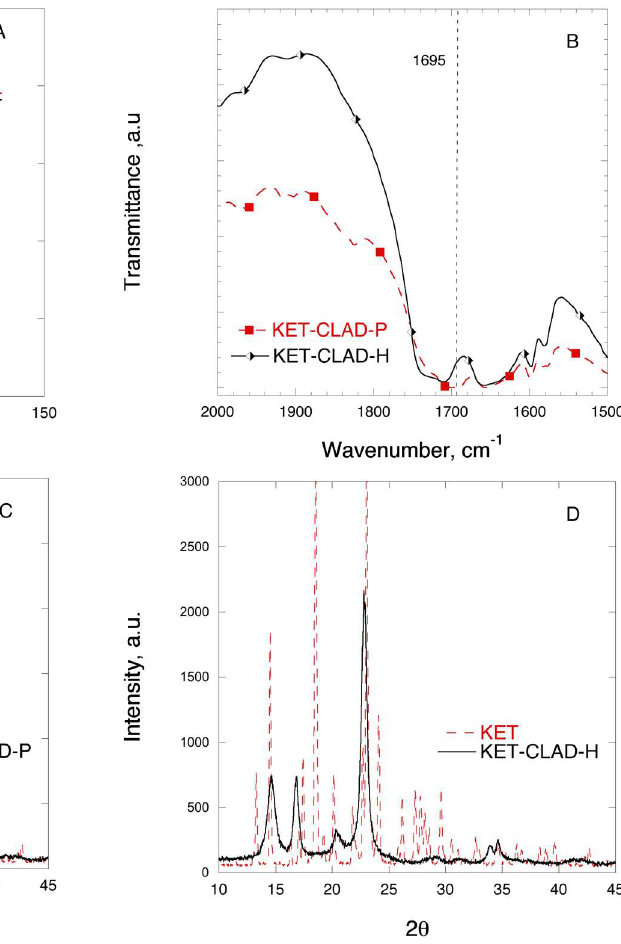
Figure 8. Solid-state analysis of KET-CLAD 10% w / w mixtures: ( A ) DSC, ( B ) FTIR, ( C ) XRD for P-mixture, and ( D ) XRD for H-mixture. The symbols are only a guide for the eye.